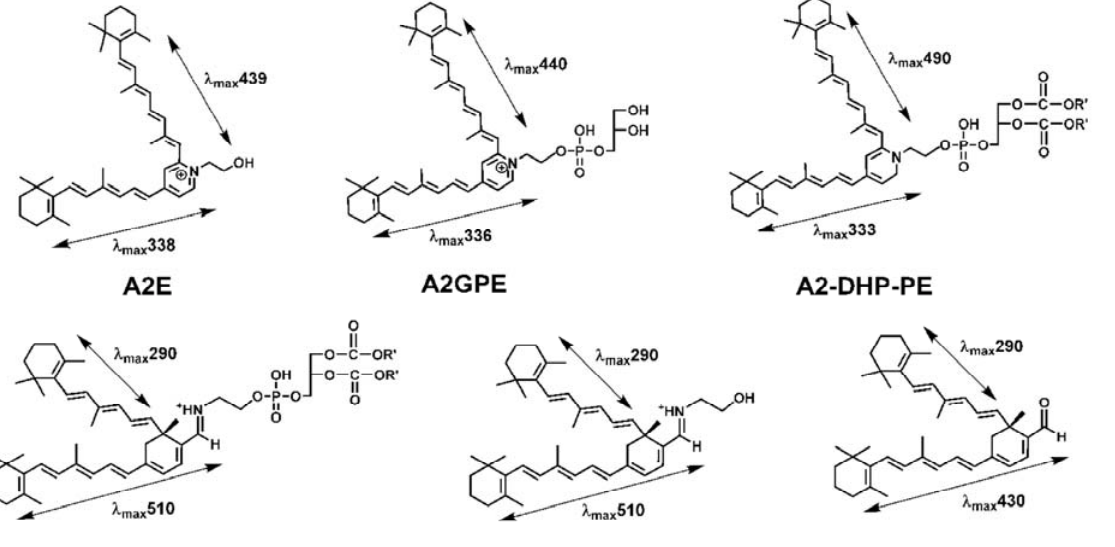
Figure 2. Structures and absorbance maxima ( λ max ) of some bisretinoid fluorophores in retinal pigment epithelium (RPE) lipofuscin. Absorbance maxima can be assigned to each of the side-arms of the